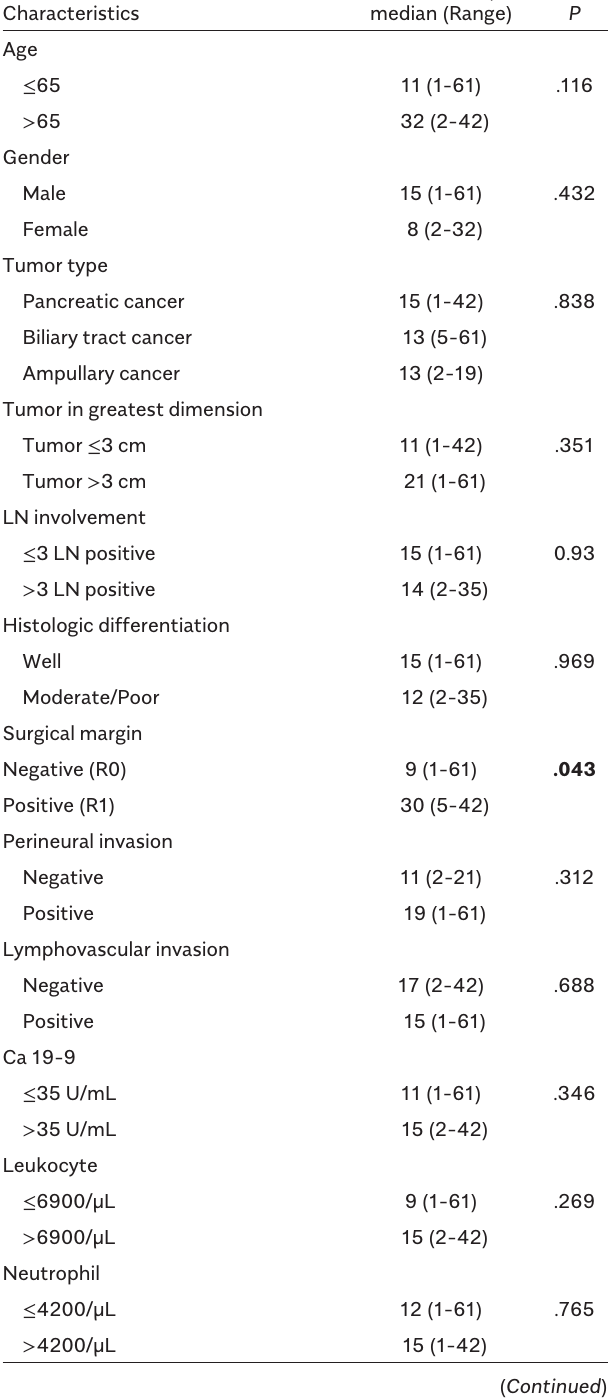
Characteristics